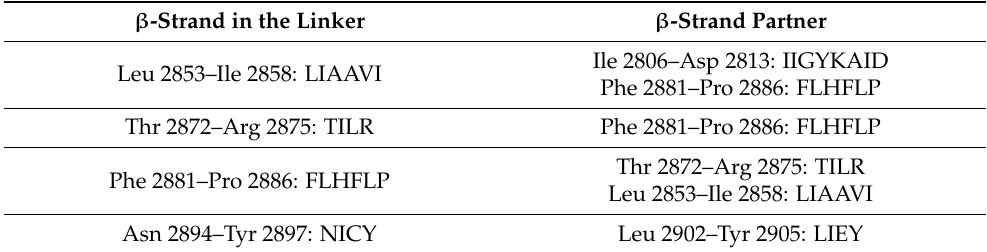
Table 2. The β -strands and their partners in the linker (residues 2856–2896) of the nsp4 lumenal region predicted in complex with the nsp3 lumenal region using